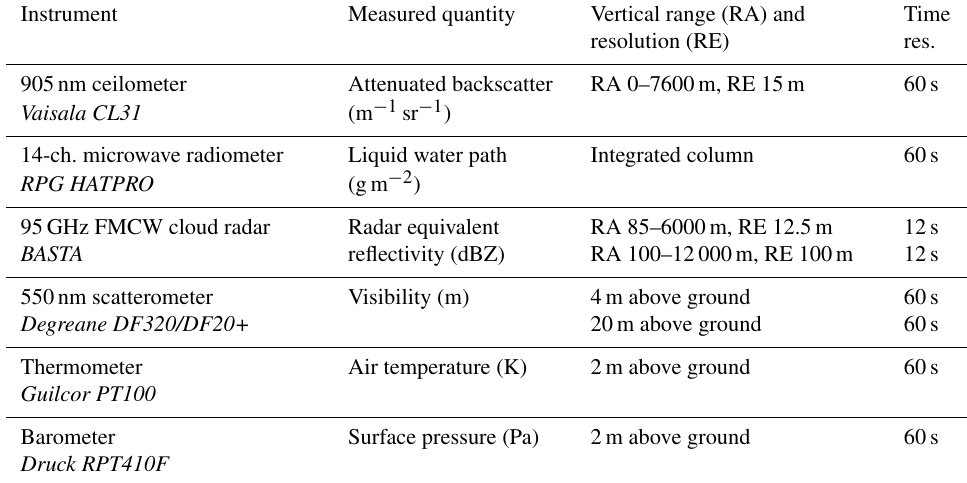
Time resolution (RE) res.